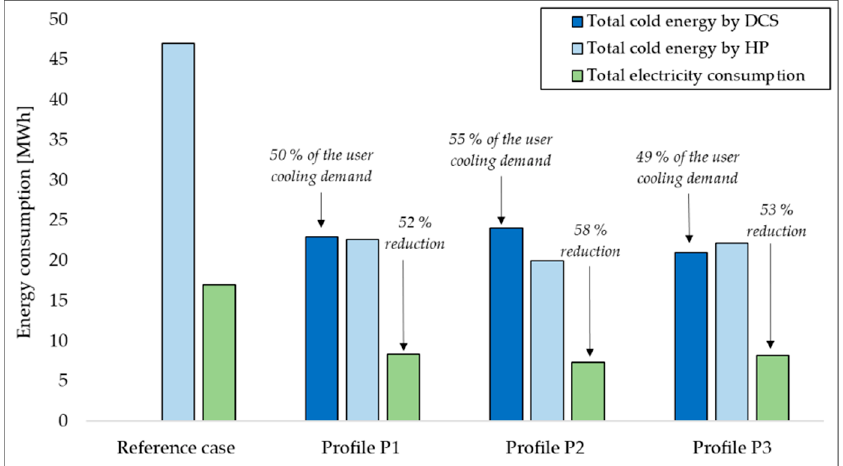
Figure 5. Total district electric consumption and users’ cold energy demand divided into the share provided by DCS and by the backup systems (i.e., HP) with different free cooling power profile (months of July and August).